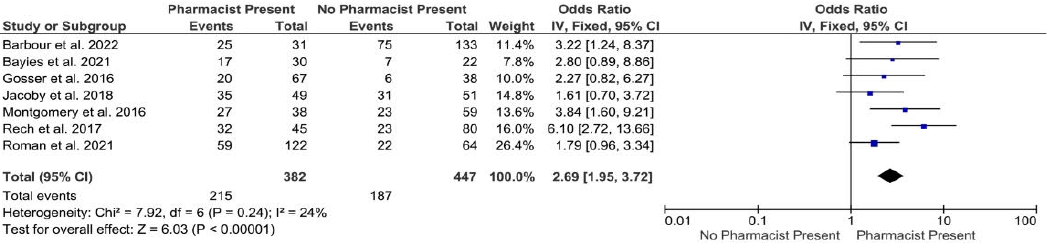
Figure 2. Forest plot illustrating the impact of pharmacist involvement in DTN for thrombolytic therapy where the number of events listed is DTN < 45 min and the total represents the number of cases in each group.